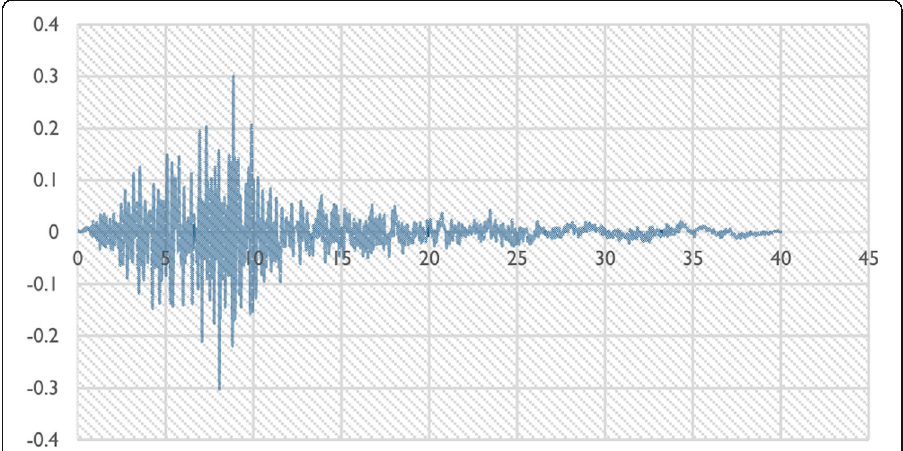
Fig. 13 Scaled artificial accelerogram (P.G.A. = 0.30